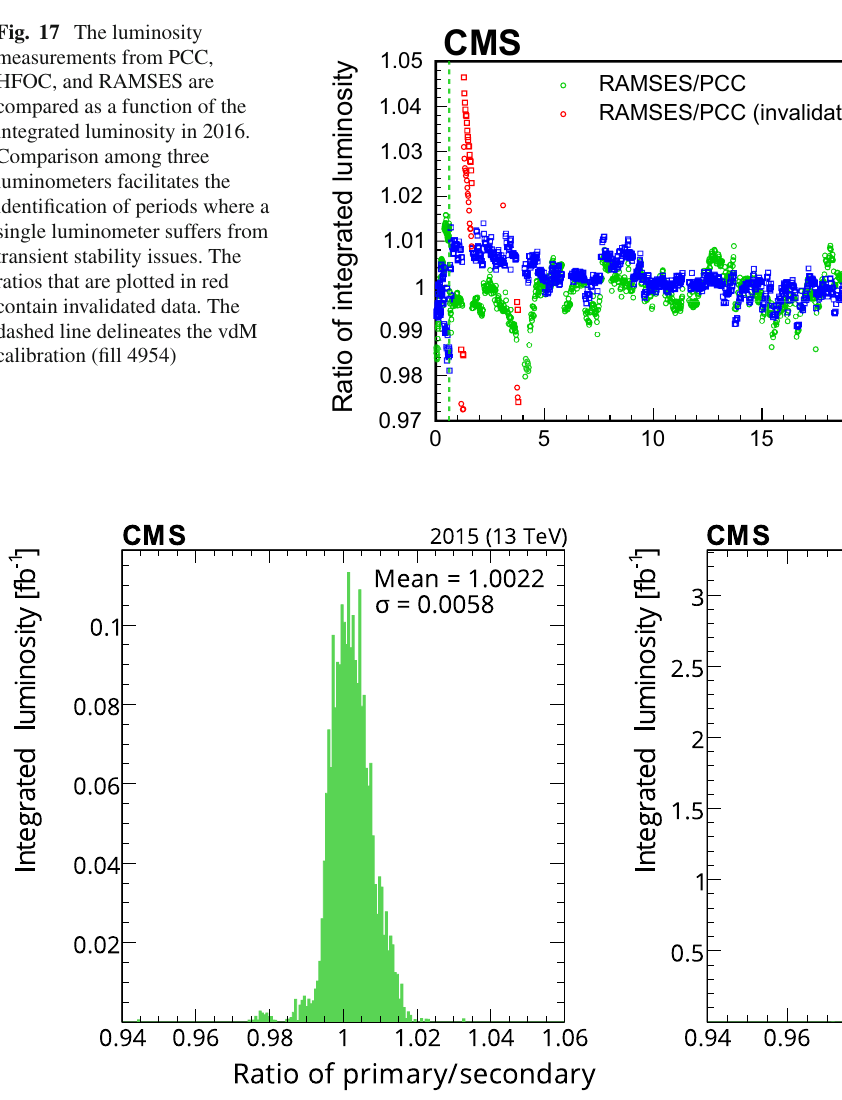
PCC/RAMSES), and the right plot shows the 2016 results (principally PCC/HFOC). Each entry is weighted by the integrated luminosity for the time